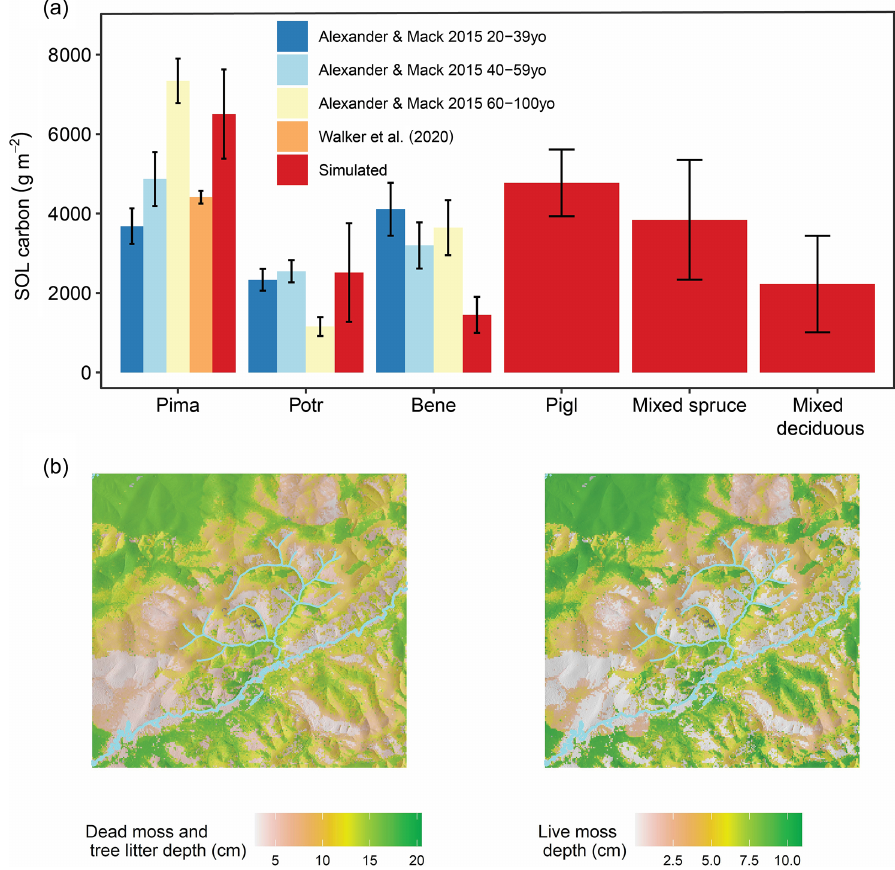
Figure 6. (a) Observed and simulated surface organic layer carbon as a function of dominant forest type. Bars and whiskers show mean SOL carbon ± 1 standard error due to limited availability of raw observational data. Simulated SOL carbon is from simulation year 300 in a 61000ha forested landscape in interior Alaska. Observations are from field sampling in other boreal forest stands. (b) Simulated dead moss and tree litter depth and live moss depth are from simulation year 300 in a 61000ha forested landscape in interior Alaska. Together, these two variables comprise the total surface organic layer in